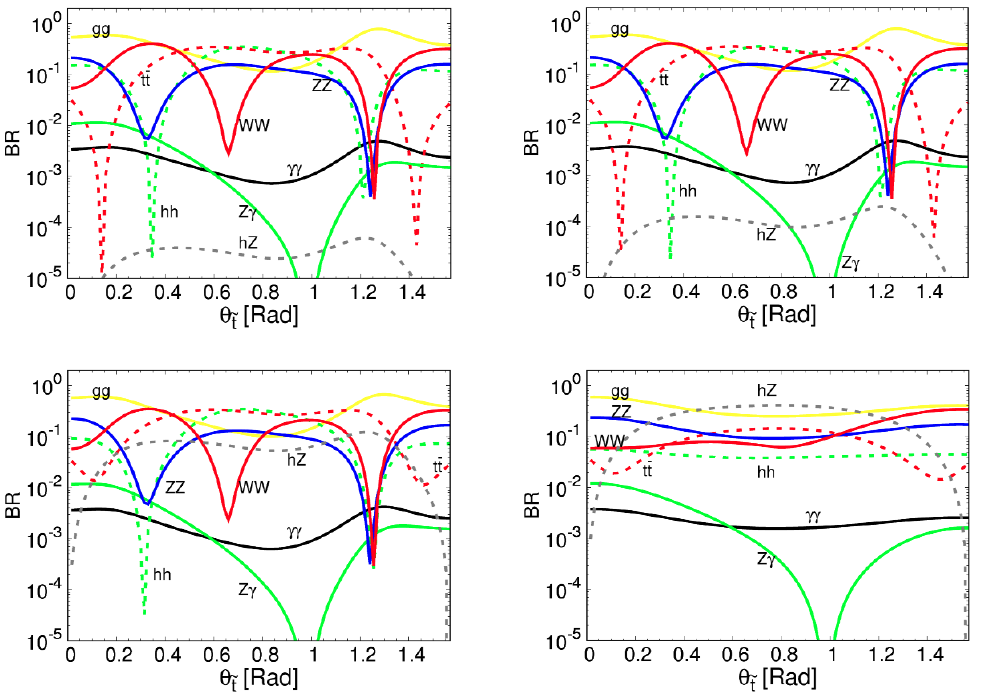
= 600 GeV. The other relevant parameters are e t 1 = 650 GeV in the lower- e t 2